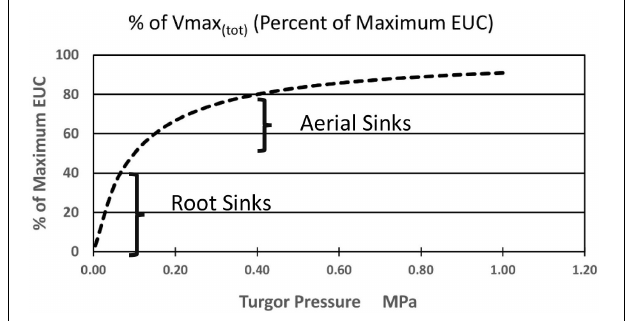
FIGURE 4 | Hypothetical effect of turgor pressure on the value of Vmax ( tot ) of the membrane-bound unloading enzyme system (i.e., transporters) in various metabolic